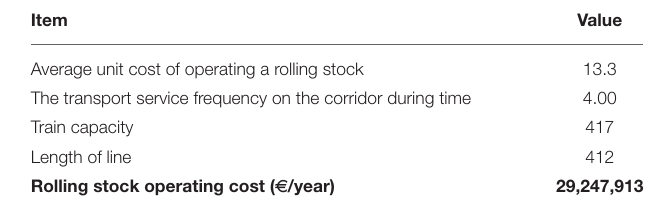
TABLE 14 | The rolling stock operating cost ( e /year).